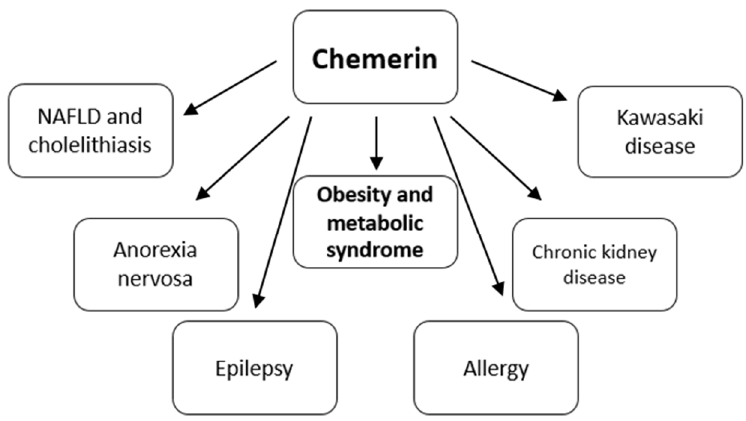
Figure 2. Involvement of chemerin in various diseases in children and adolescents.